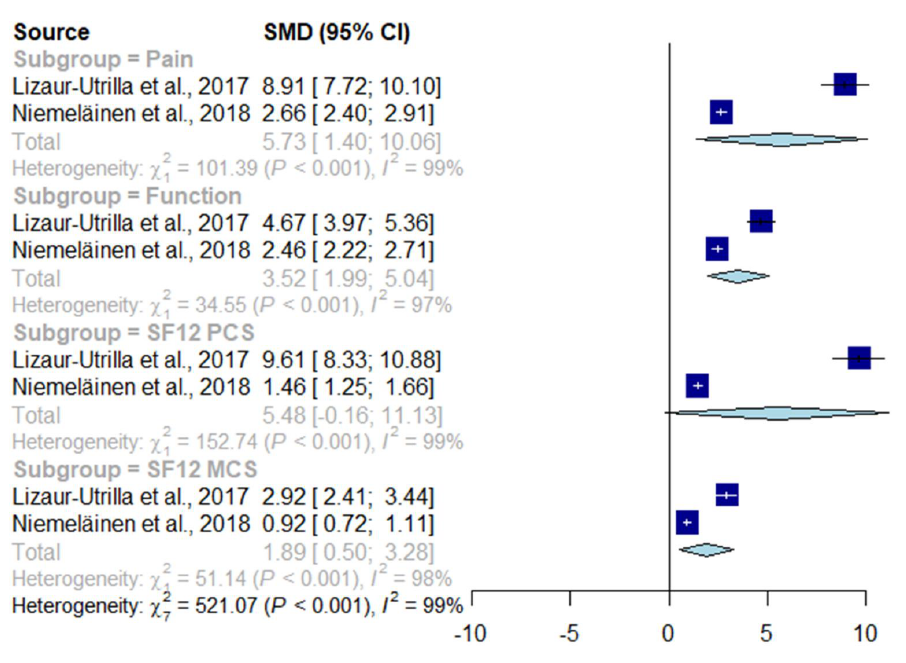
Figure 2. Forest plot of change in patient-reported pain, function, and quality of life (physical health and mental health) following primary total knee replacement (TKR), assessed using standardised mean di ff